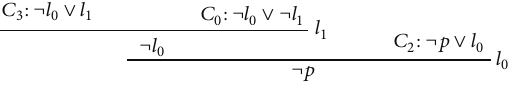
Figure 3: Resolution steps for learning ¬𝑝